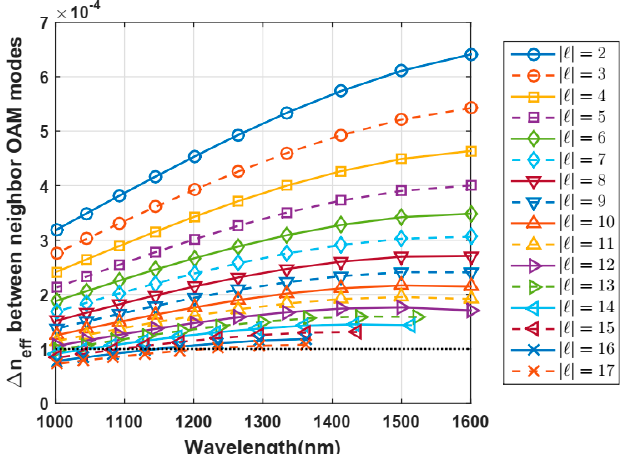
Figure 5. Effective index difference between neighbor OAM modes as a function of light wavelength for the first 18 modes.